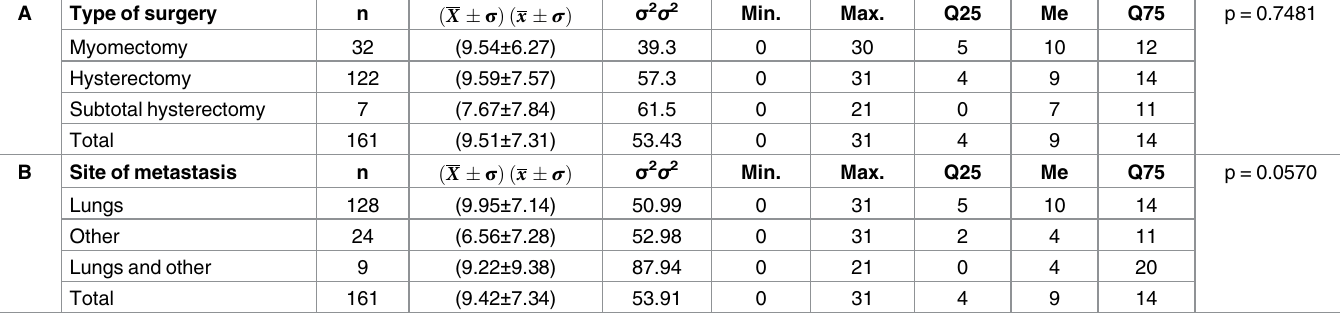
Table 4. Descriptivestatistics of the time from the primary surgery to BML diagnosis, grouped based on the type of surgery and the site of metastasis. A Type of surgery Myomectomy Subtotal